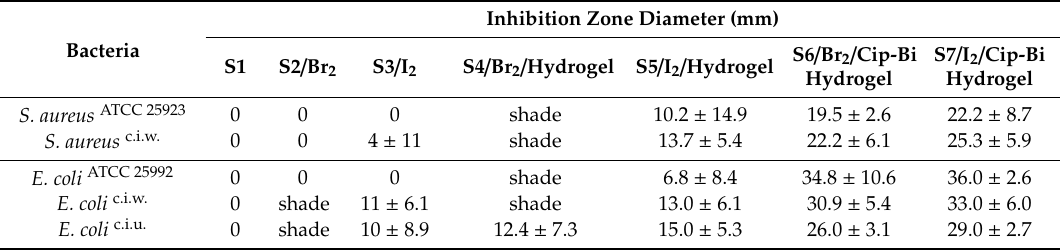
Table 3. Analysis of the effect of ciprofloxacin-bismuth (Cip-Bi)-modified dressing samples on the growth of the tested Gram-positive and Gram-negative bacteria (mean ± relative standard deviation %, n = 5).